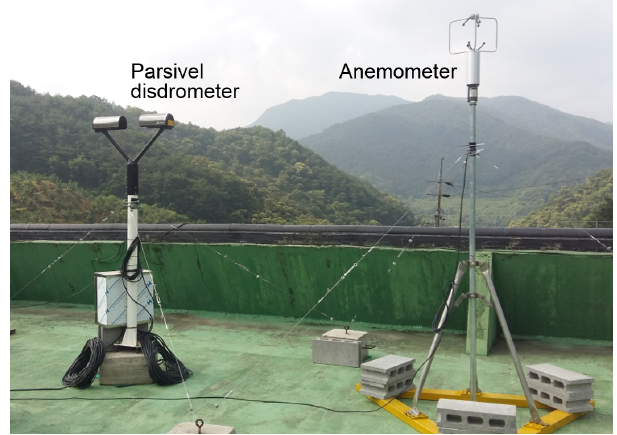
Figure 1. Picture of a Parsivel disdrometer and an ultrasonic anemometer that were installed at an observation site around Mt. Jiri during the intensive observation